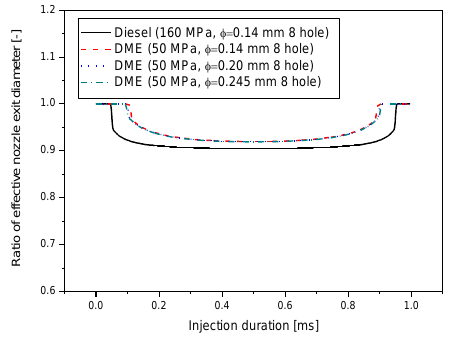
Figure 10. The ratio of effective nozzle exit diameter during injection.